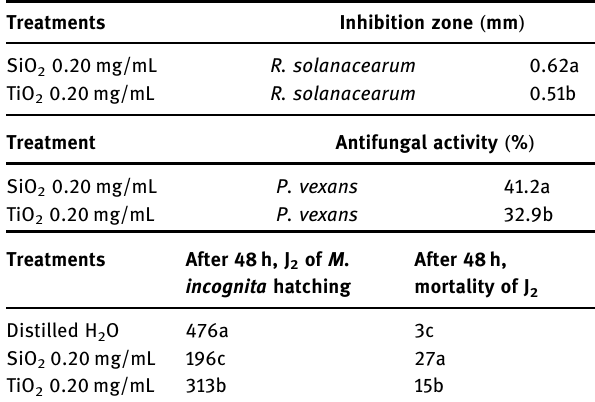
Table 1: Impacts of SiO 2 - NPs and TiO 2 - NPs on fungus and bacteria in vitro , as well as e ff ects of both NPs on M. incognita hatching